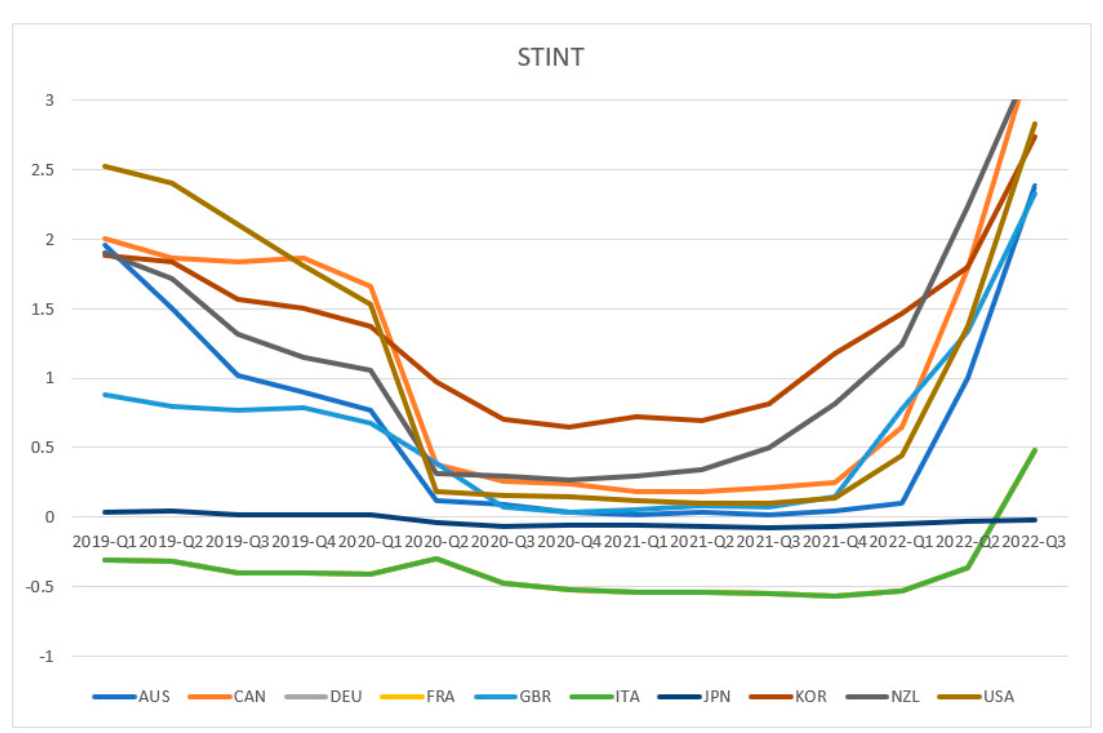
Figure 1. Short-term interest rates of ten countries from 2019 Q1 to 2022 Q3. Source: data from OECD (2022a) [36]. Legend: Australia (AUS), Canada (CAN), Germany (DEU), France (FRA), Great Britain (GBR), Italy (ITA), Japan (JAP), South Korea (KOR), New Zealand (NZL), and the United States of America (USA).